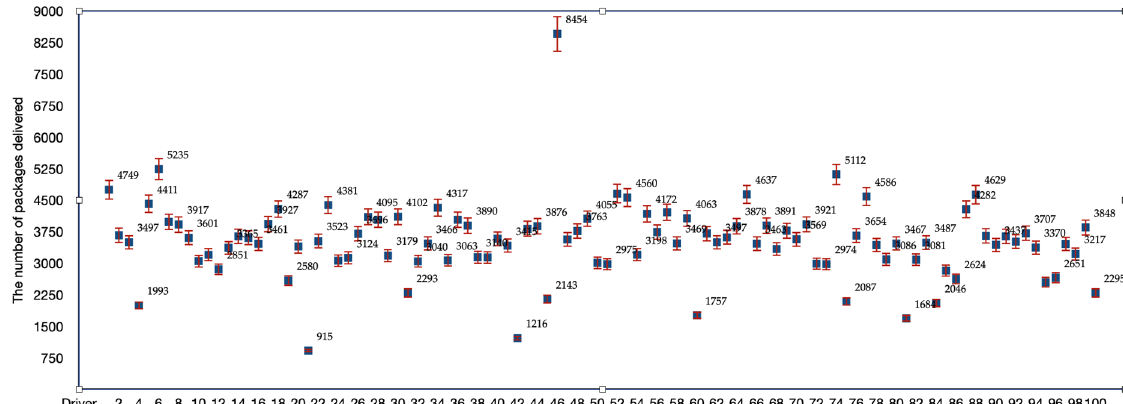
Figure A1. The number of packages delivered by the e-scooter.